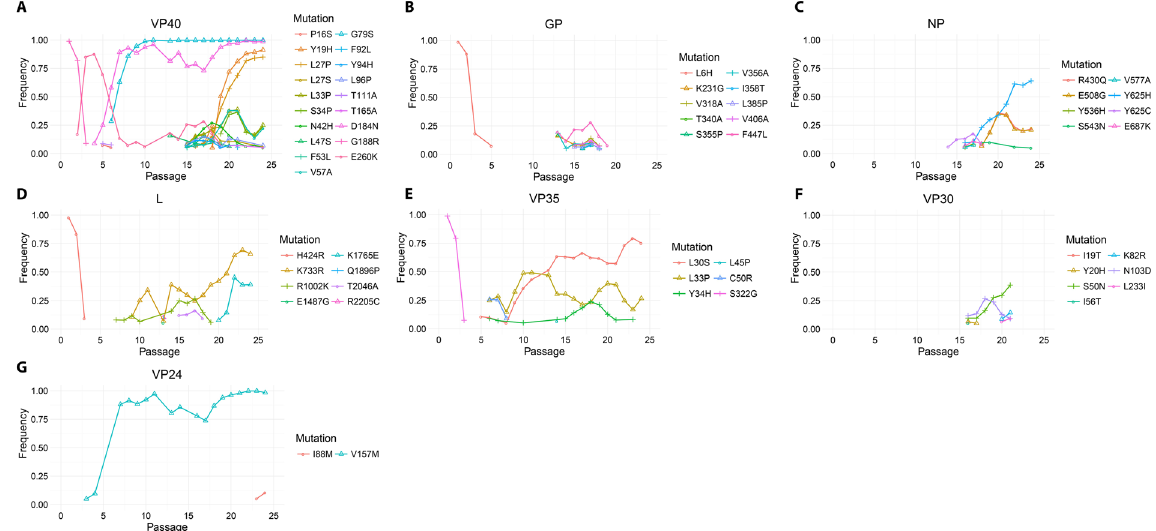
Figure 2. Non-silent mutations in coding regions over virus passages in SCID mice. Frequency of reads containing a mutation over depth as a function of passage for: ( A ) VP40; ( B ) GP; ( C ) NP; ( D ) L; ( E ) VP35; ( F ) VP30; and ( G ) VP24. For each protein, the mutations are colored from the most N-terminal (Red) to the most C-terminal (Pink).